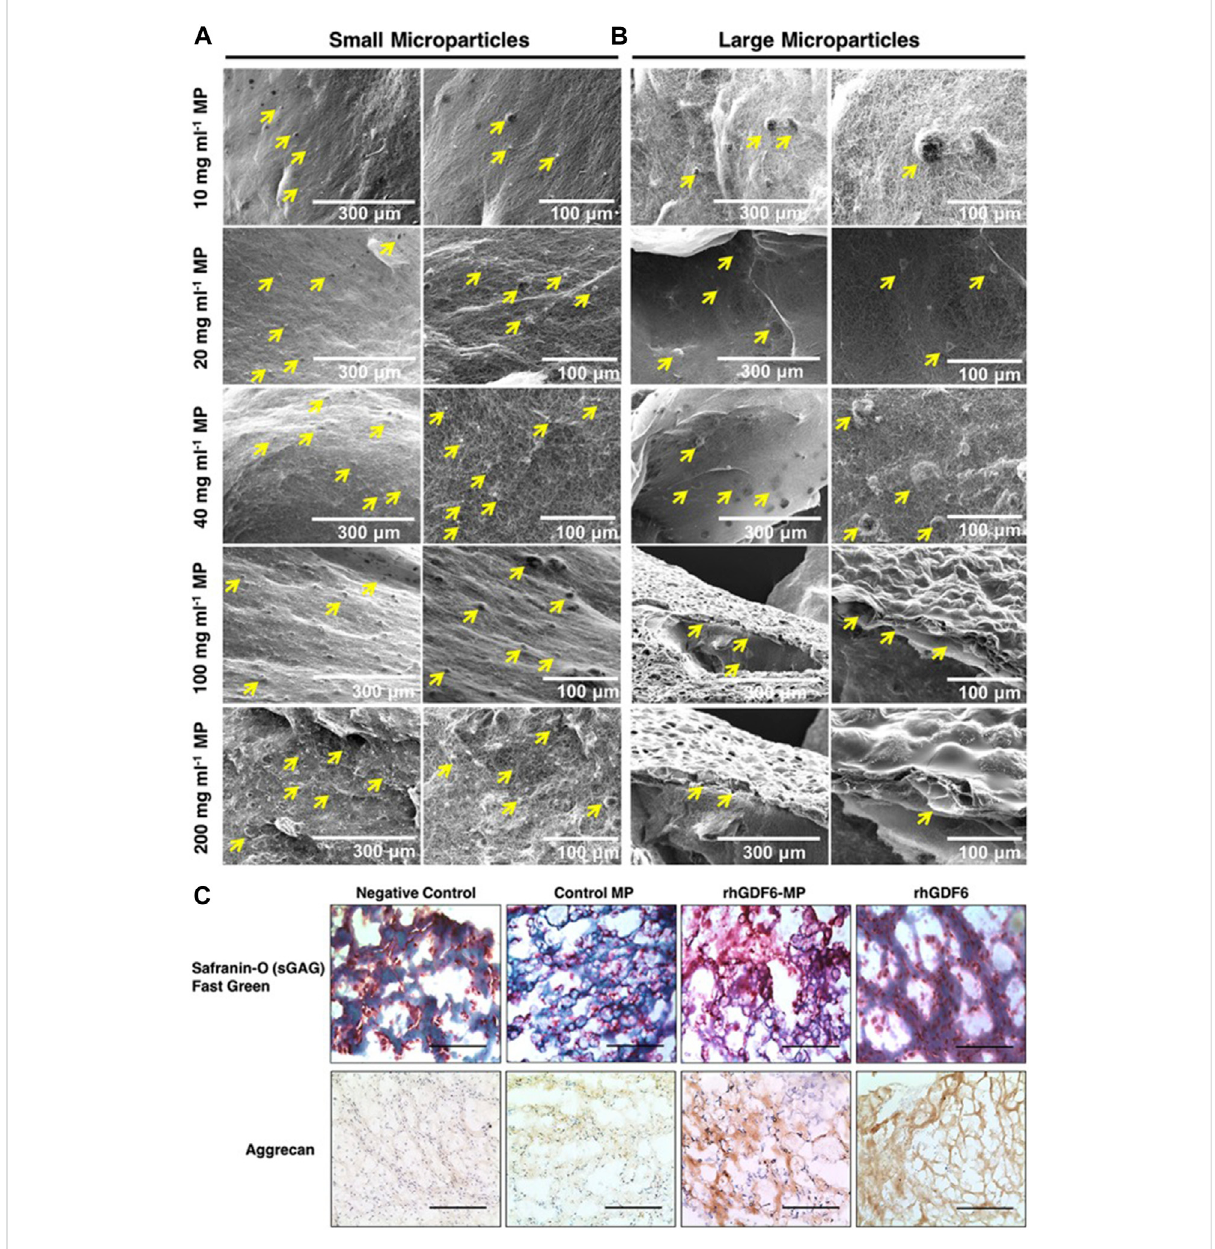
FIGURE 5 Thebindingabilityofdifferentconcentrationsofsmall (A) andlarge (B) microspherestocollagengelunderscanningelectronmicroscopy.After 14 days of culture, the microspheres containing rhGDF-6 showed more ideal target substances expression in both histological and immunohistochemical staining (C) . Scale bars = 300 μ m. Reproduced with permission from (Hodgkinson et al.,